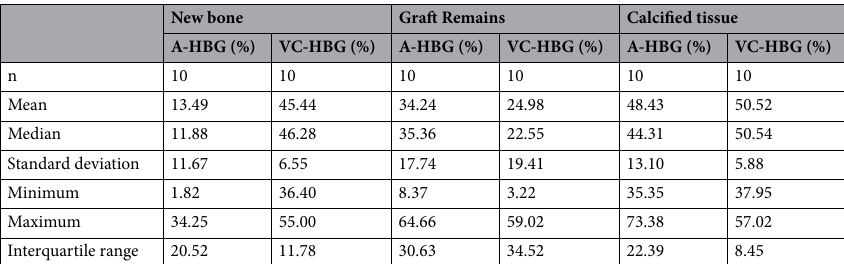
New bone Graft Remains Calcified